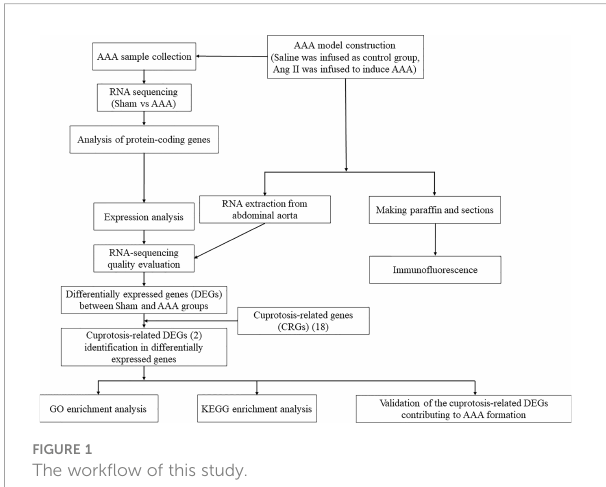
FIGURE 1 The work fl ow of this